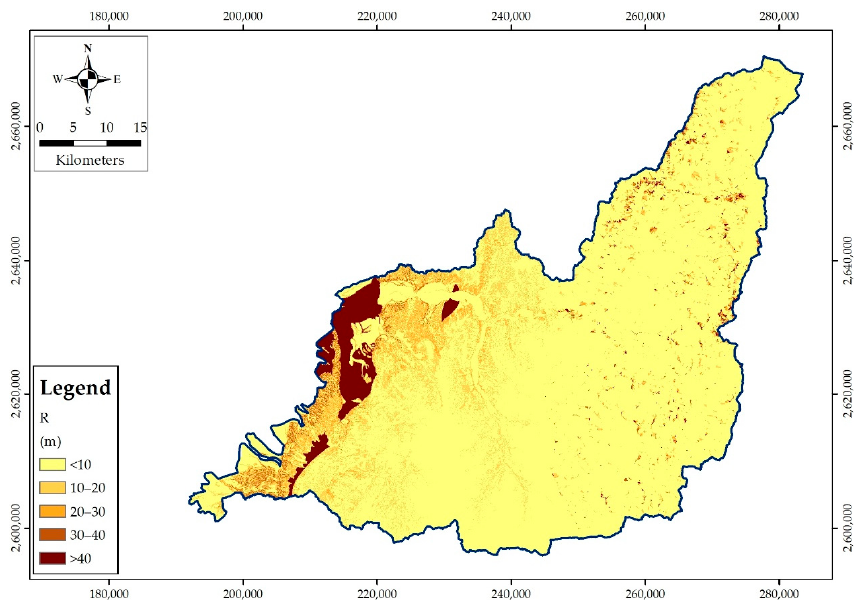
Figure 10. Regolith thickness distribution of the study area.